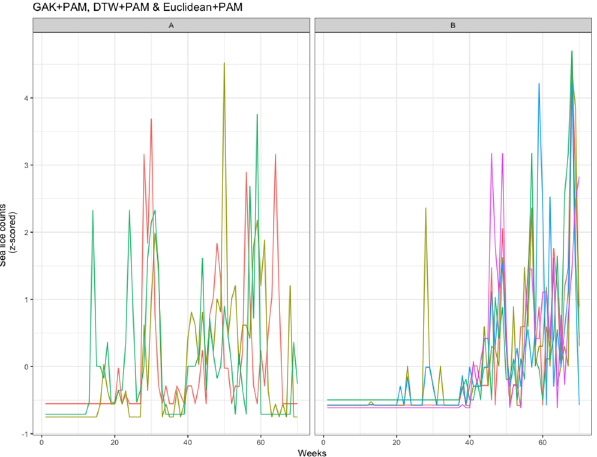
Fig 4. Farm I clustering for 2016-2017. Time-series plots for the most stable clustering algorithm for Farm I, production cycle of 2016-2017.